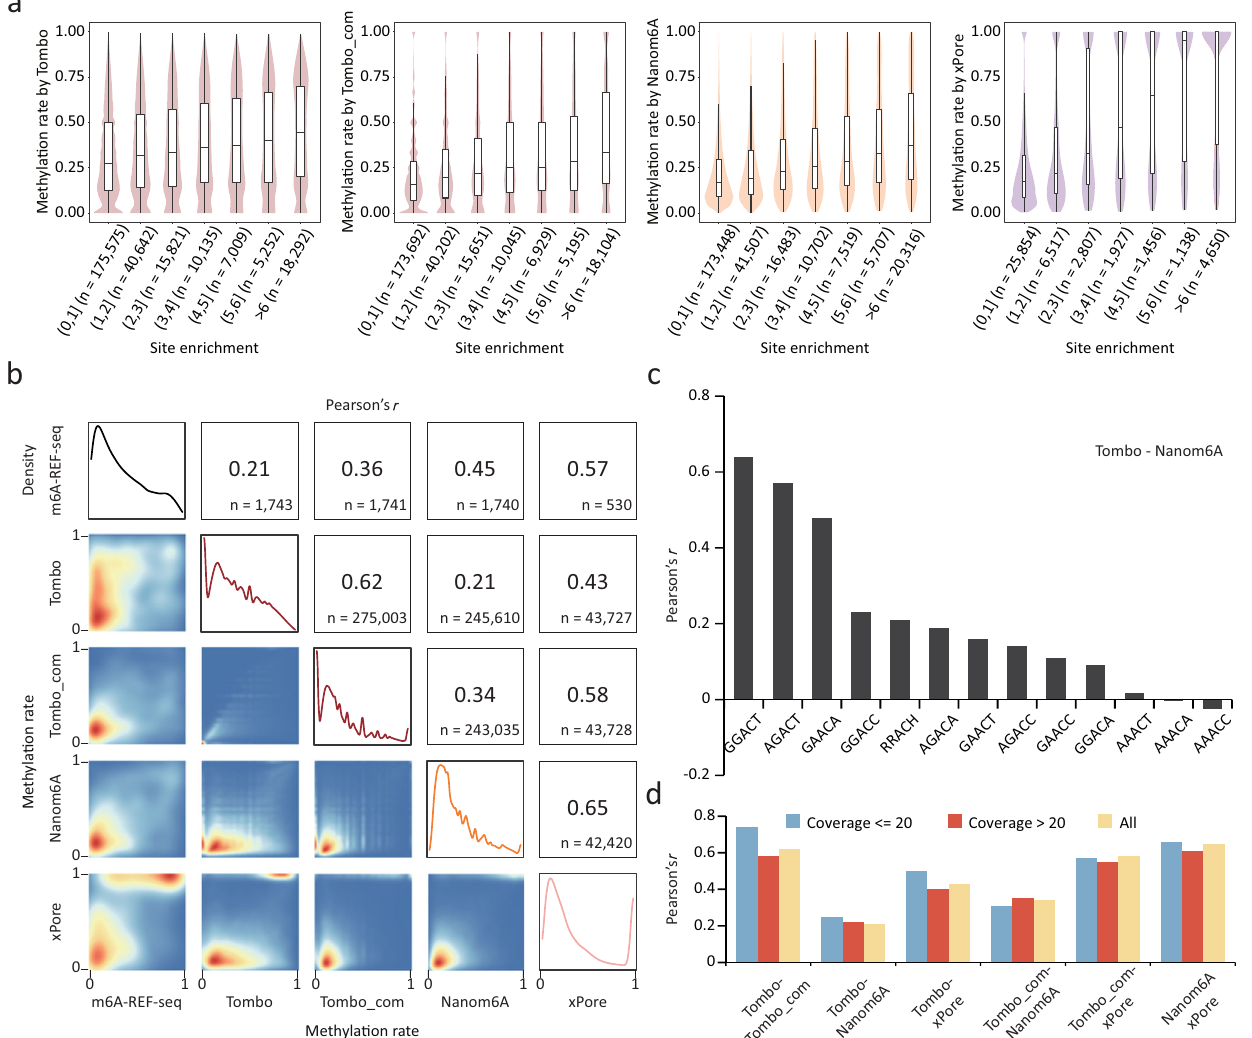
Fig. 5 | Performance of Tombo/Tombo_com, Nanom6A and xPore for m6A quanti fi cation. a The distribution of methylation rates determined by each of the threetools.m6Asitesareclassi fi edintocategoriesaccordingtoenrichmentscores derivedfromMeRIP-seq.Violinplotsshowthedistributionofdetectedmethylation rates. In the boxplots, the lower and upper limits represent the 25th and 75th percentiles, respectively; the center line represents the median; and upper and lower whiskers indicate ±1.5×IQR. The number of sites occurring in each peak category are indicated in parentheses. b Correlations of methylation rates derived from m6A-REF-seq and those from each of the three tools. Pearson correlation